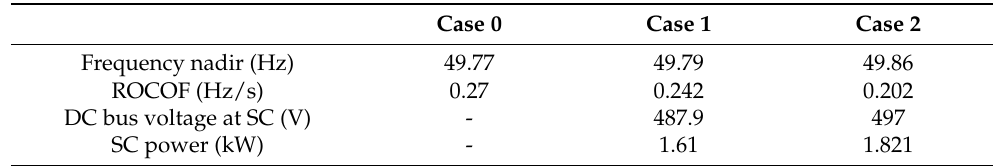
Table 5. Comparison table for the sudden load increase.